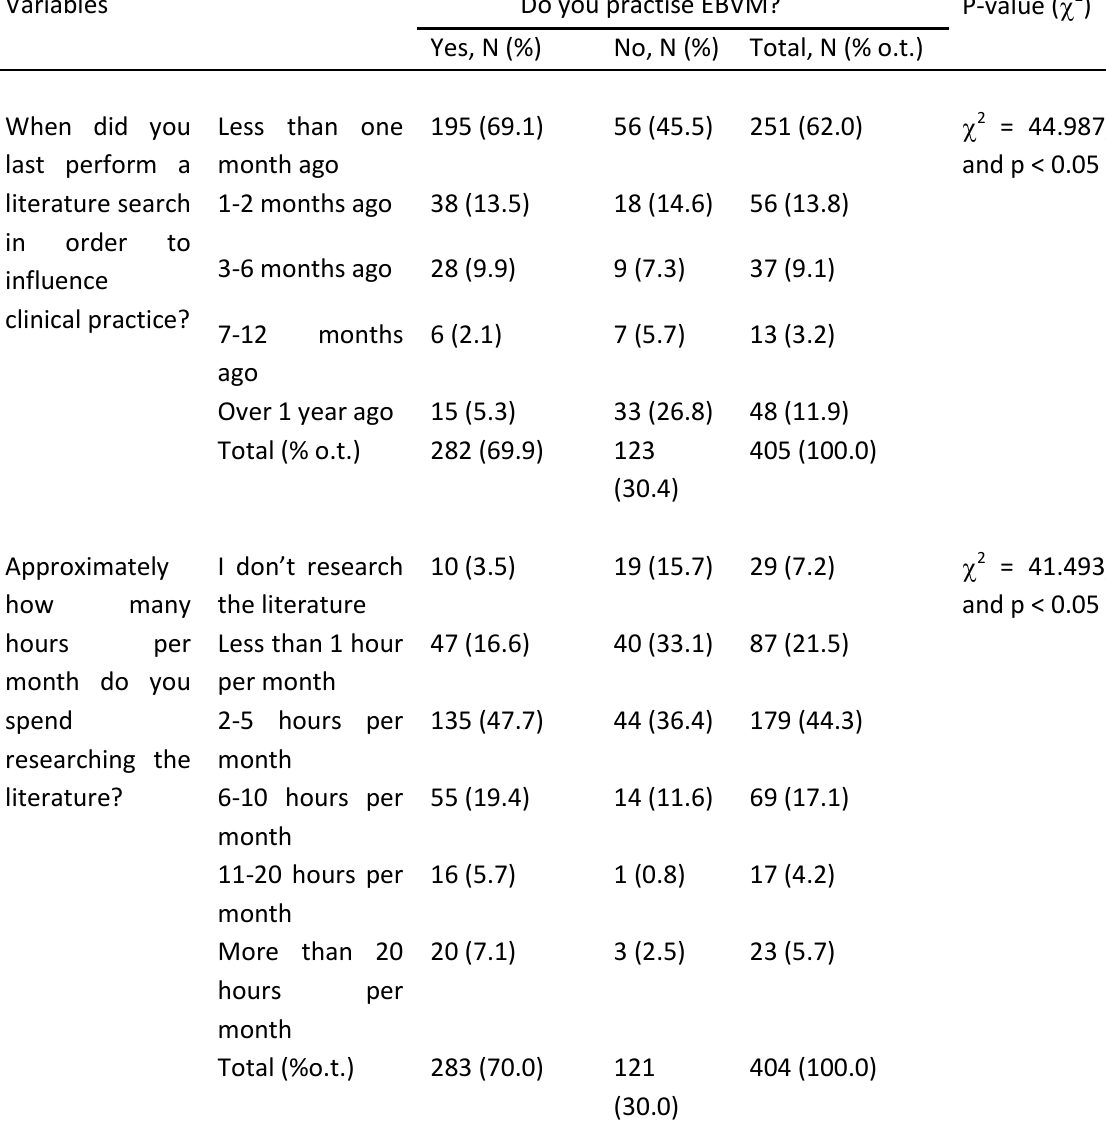
Table 2 : Last literature search and time spent on research Variables Do you practise EBVM? P-value (  2 ) Yes, N (%) No, N (%) Total, N (%